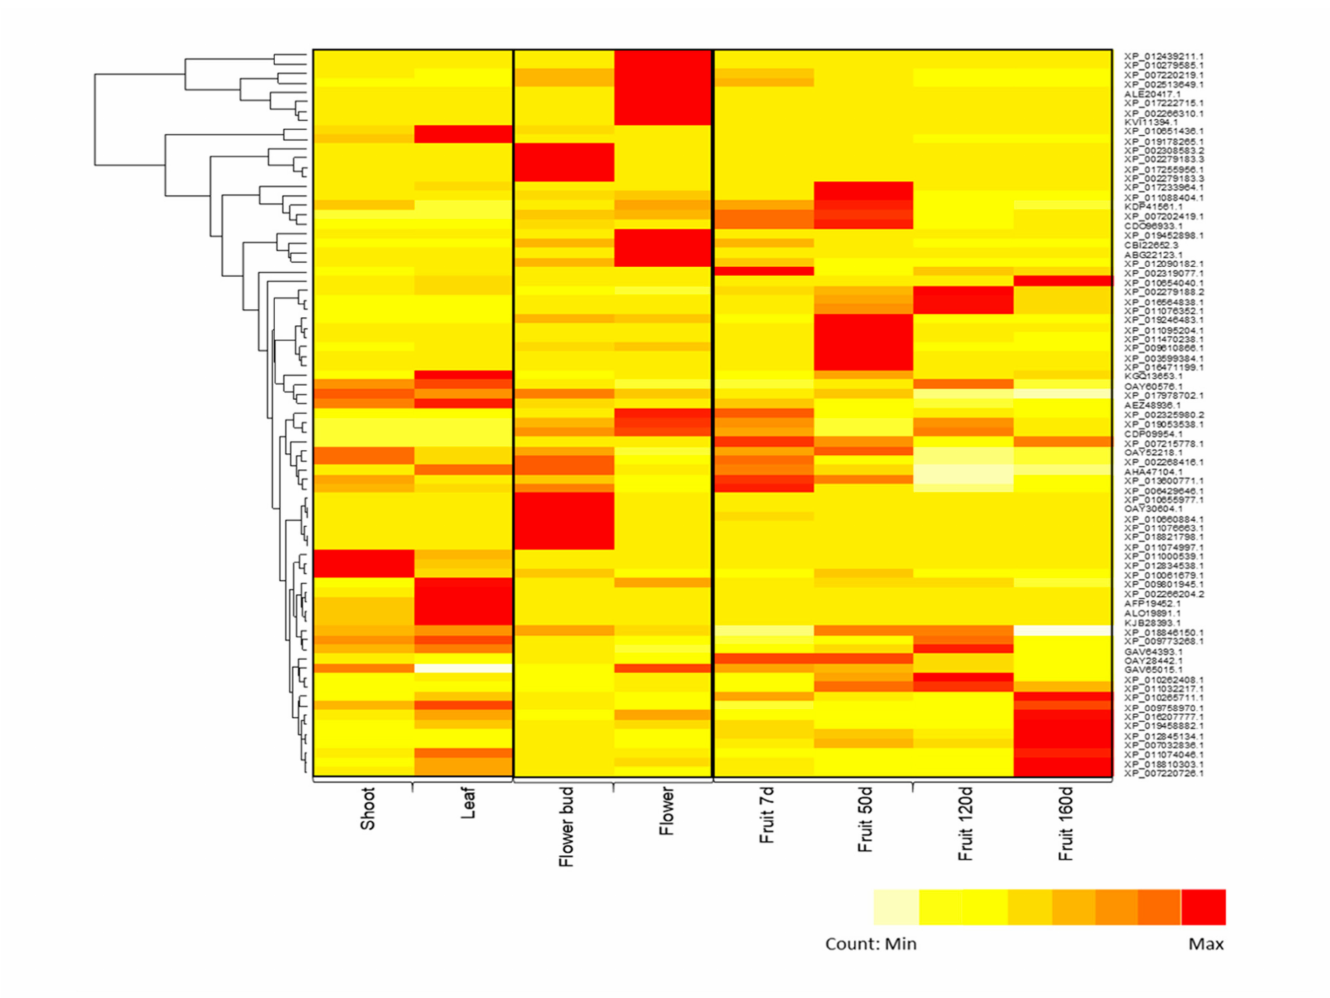
Figure 6. Summary of the top-hit genes up- and down-regulated considering shoot, leaf and fruit tissues (d7, d50, d120 and d160). Light yellow color indicates a minimum value of counts while red indicates a maximum